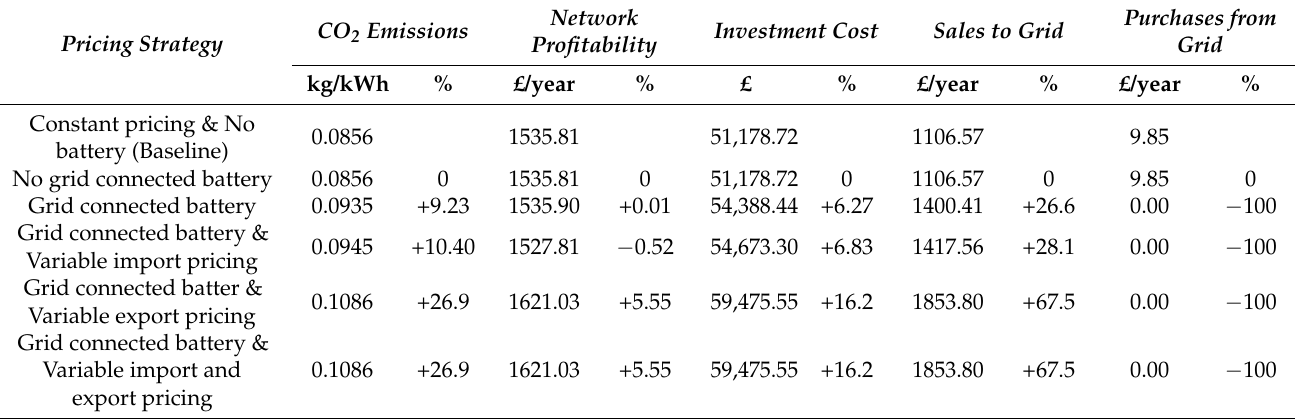
Table 12. Comparison of economic and environmental impacts for the grid connected battery network scenarios. CO 2 Emissions Pricing Strategy